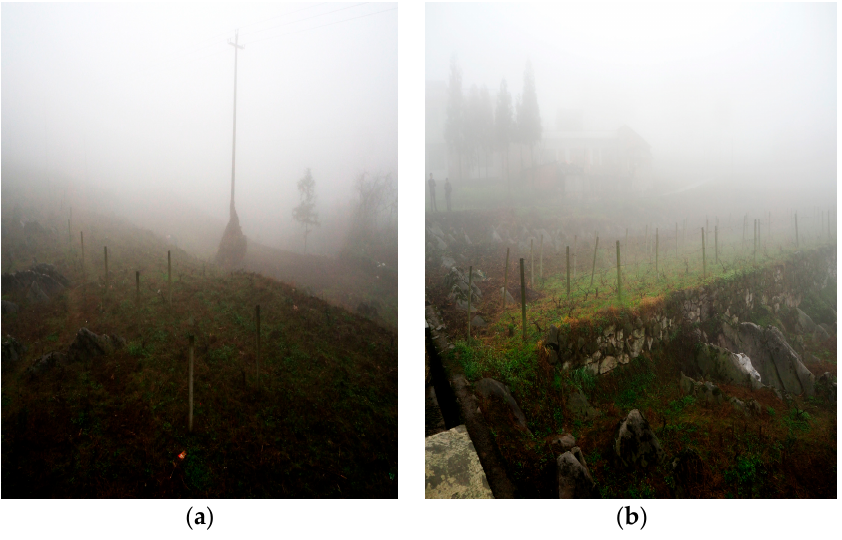
Figure 13. ( a , b ) Scenes of the “Terracing of cultivated sloping land” project in Kaiyang County, Guiyang.